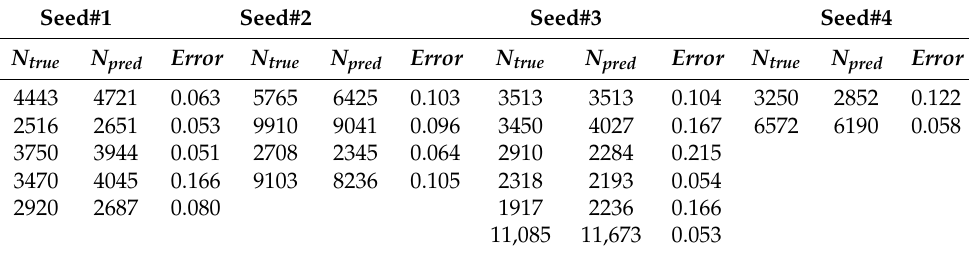
Table 4. Ultimate strengths of samples whose relative error exceeds